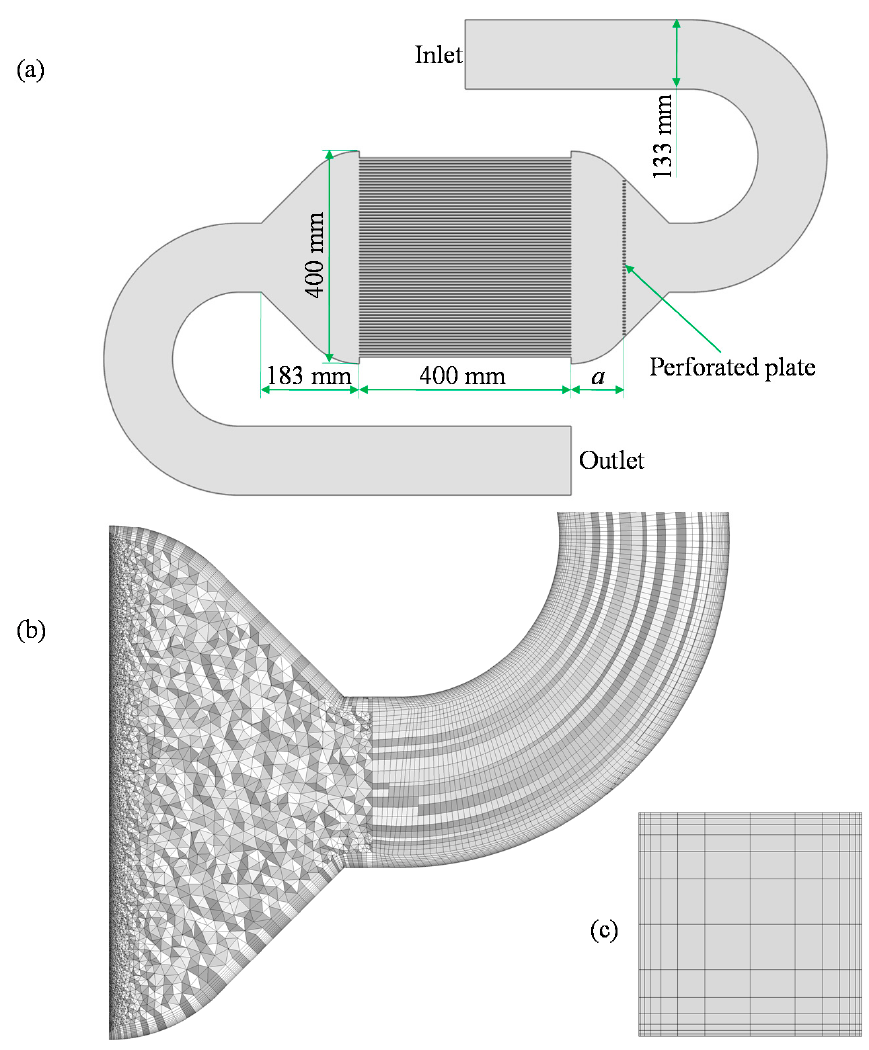
Figure 4. ( a ) Vertical and middle cross-section of the flow domain, ( b ) Mesh view in the middle plane in the inlet region, ( c ) Mesh view in the cross-sectional plane of one horizontal flow channel.